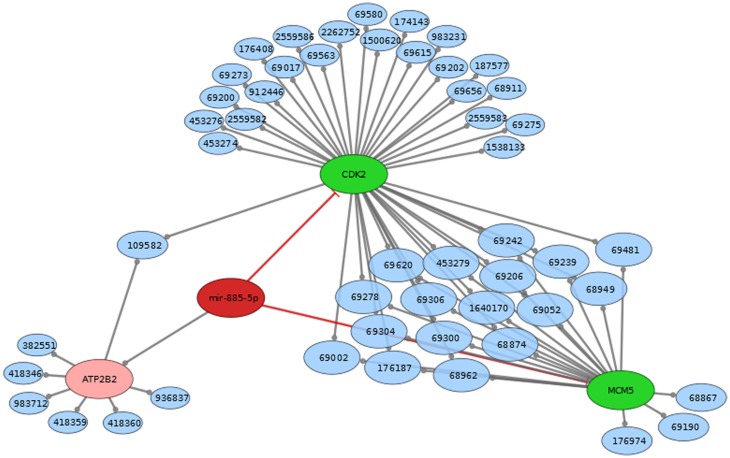
Mir-885 comes from an intron in ATP2B2 (both red). Mir-885 has two known targets (green). These targets are part of a number of reactome pathways (blue). The Number in the blue nodes can be used to access the associated reactome pathway and Table S2 in Supplementary Material provides further information for clarity. Size of blue nodes reflects the number of mir-885 targets it contains. Edges ending in circles (gray) indicate a part of relationship (e.g., CDK2 is a part of the “Activation of the pre-replicative complex” pathway, which has the reactome accession number 68962). Edges ending in straight lines (red) indicate inhibition of the target (e.g., mir-885 inhibits MCM5).